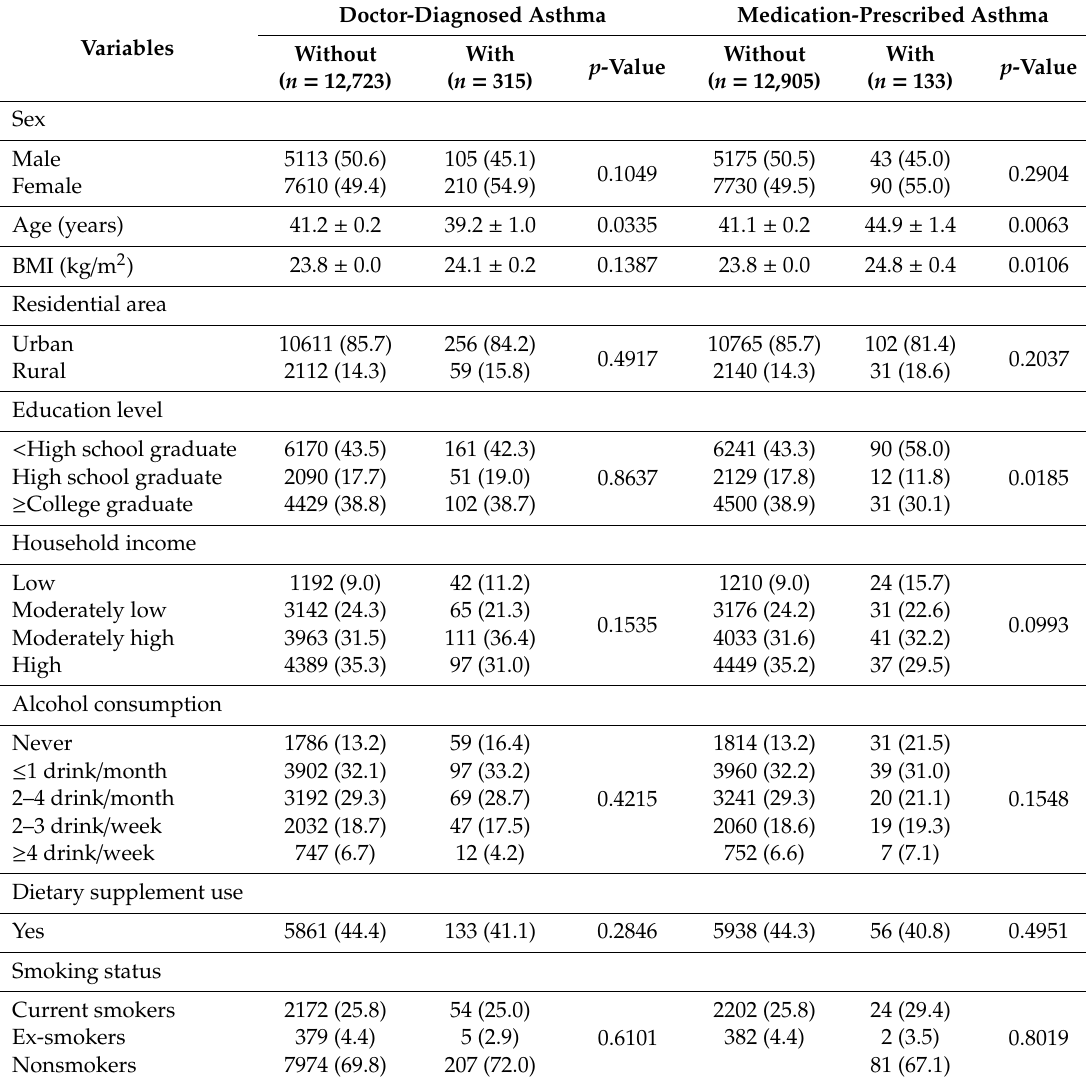
Table 1. General characteristics of the subjects according to